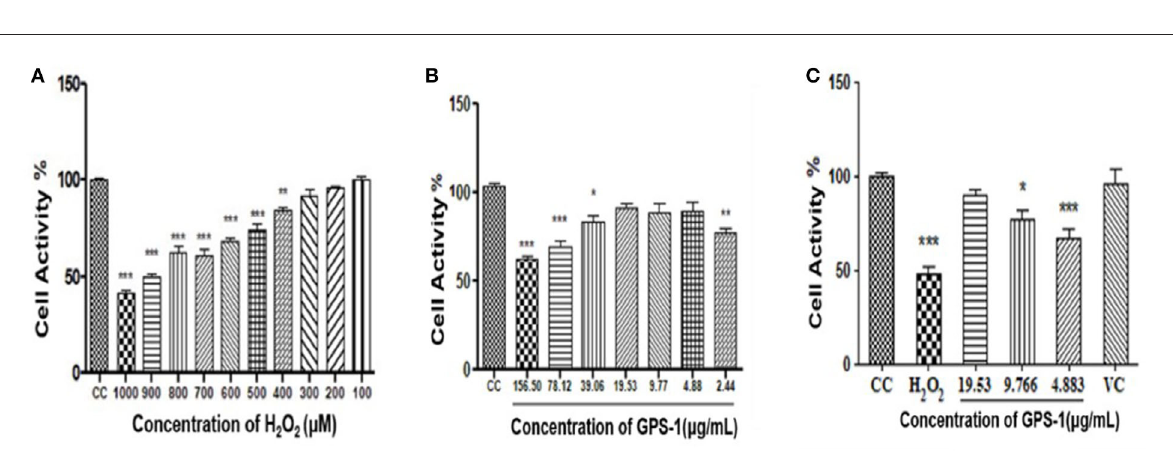
for three consecutive days, while the VC group and BC group were treated with the same amount of saline (1mL), respectively